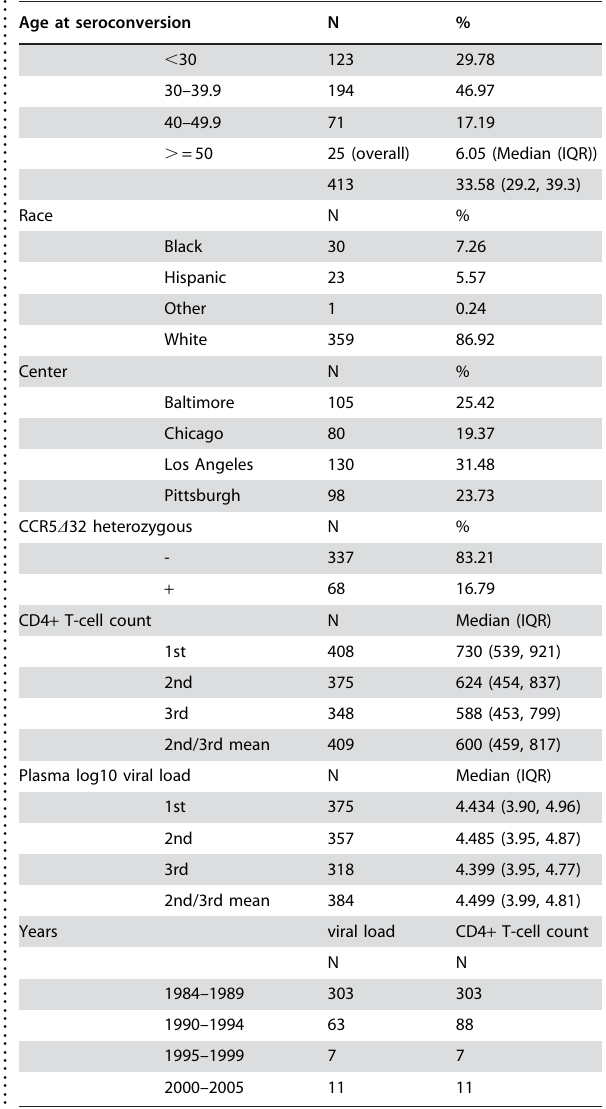
Table 1. Summary of participants and data. ... ... ... .... ... ... .... ... ... .... ... ... .... ... ... .... ... ... .... ... ...